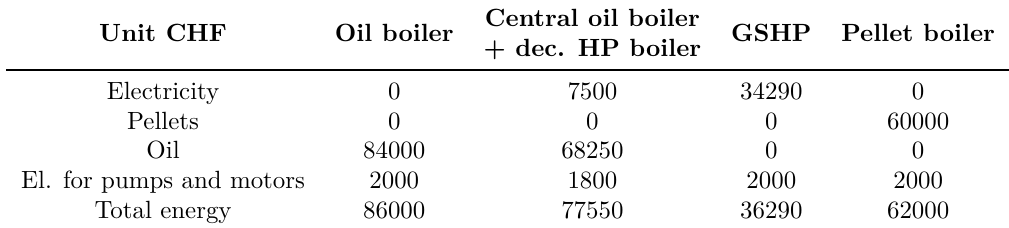
Table 2. Investment costs of different supply options (in CHF).